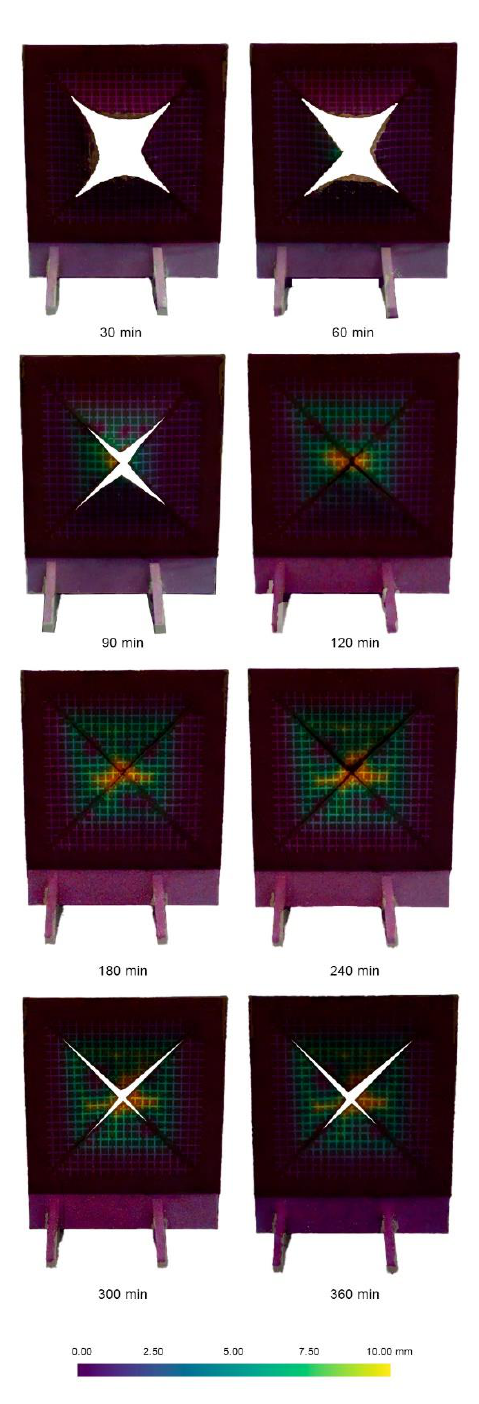
Figure 4 . From the front view of the acquisition overlying the textured map of the actuator the punctual differences in the displacements can be